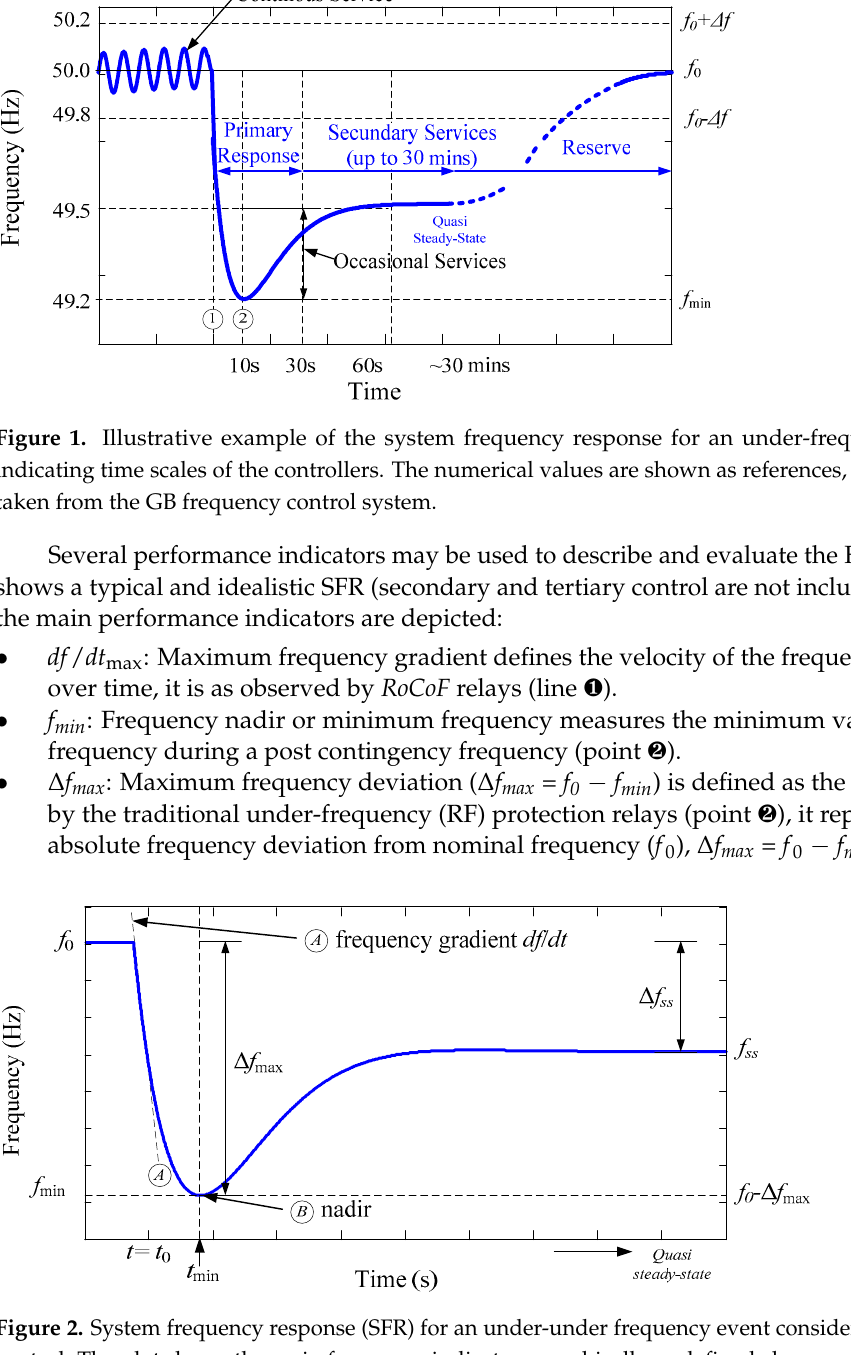
Figure 2. System frequency response (SFR) for an under-under frequency event considering primary control. The plot shows the main frequency indicators graphically as defined above.